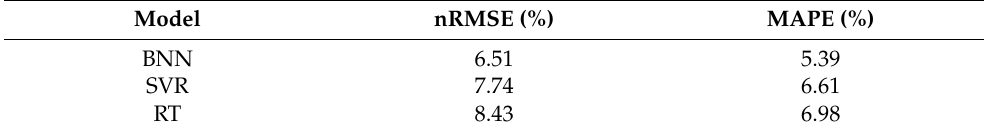
Table 4. Day-ahead photovoltaic (PV) production forecasting accuracy comparison of the machine learning predictive models trained using computed historical data, over the test set evaluation